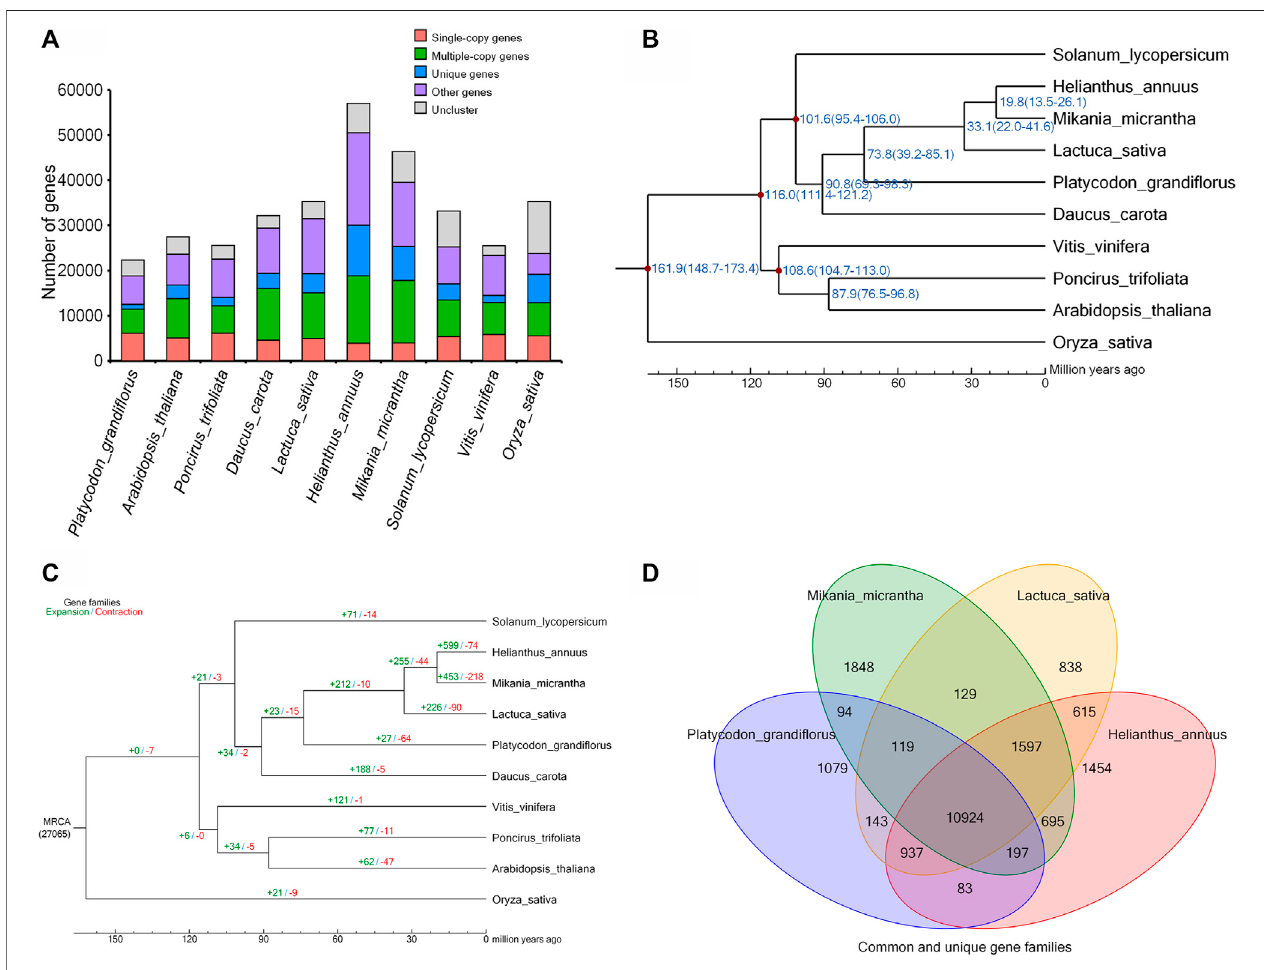
FIGURE 2 | Platycodon grandi fl orus phylogenomics. (A) The distribution of single-copy, multiple-copy, unique, and other genes in the 10 plant species. (B) Phylogenetic tree of the 10 plant species. The blue numbers denote divergence time of each node (MYA: million years ago). (C) Expansion and contraction in gene families of the 10 plant species. (D) Venn diagram represents the common and unique gene families among four closely related plants.